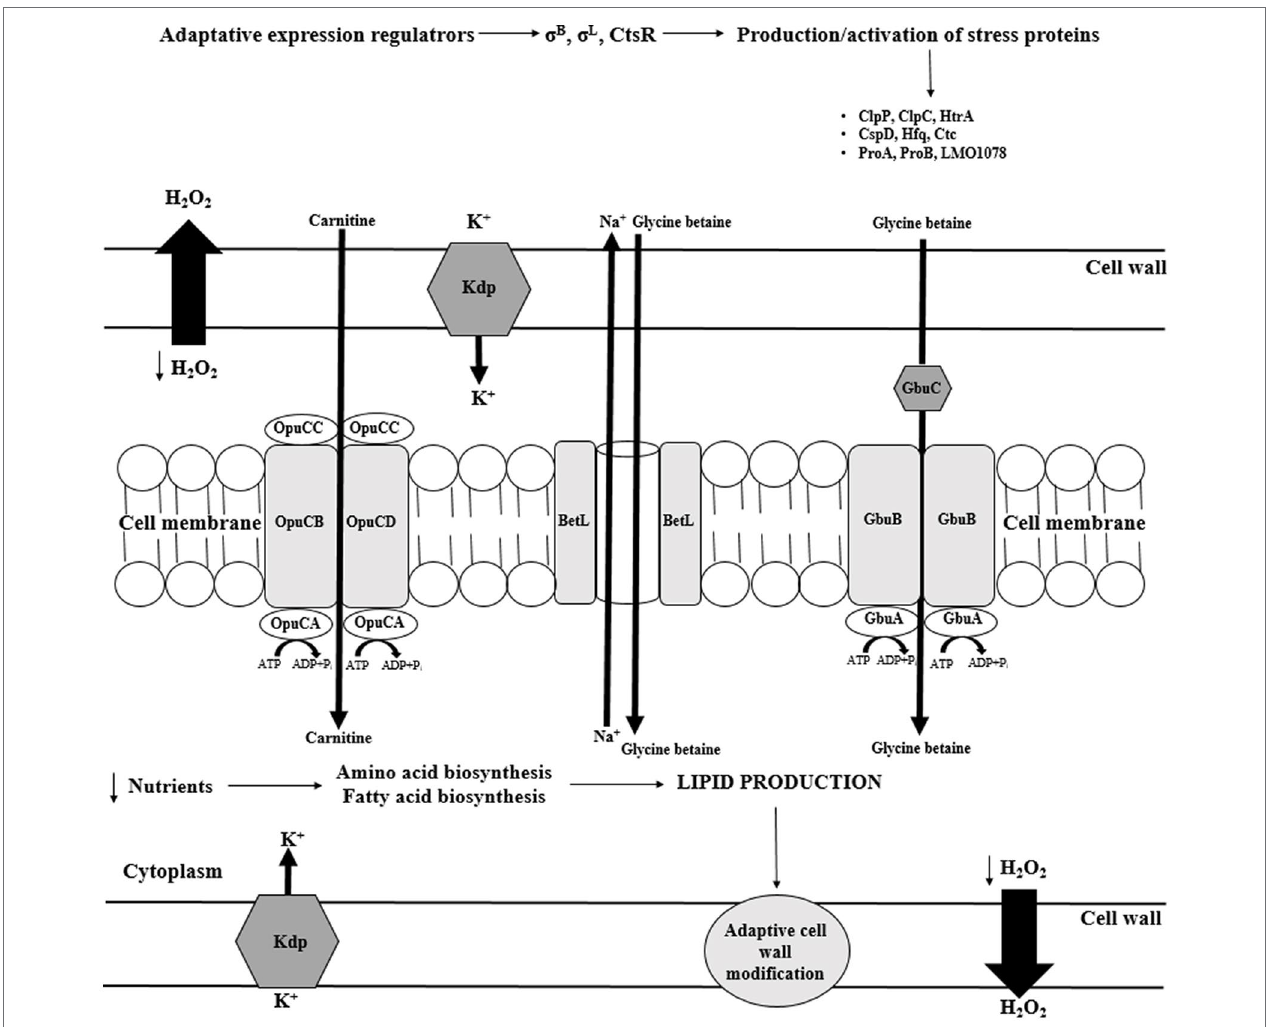
FIGURE 3 | Transport of compatible solutes in response to osmotic stress in L. monocytogenes (CtsR – negative transcription regulator; ClpP, ClpC – ATP- dependent Clp protease; HtrA – serine protease; Csp – cold shock proteins; Hfq – the RNA binding protein; Ctc – 50S ribosomal protein L25; ProBA – proline synthesis enzyme system; Kdp – operon response regulator; Gbu – glycine betaine; OpuC – ATP-dependent carnitine transporter; ATP – adenosine triphosphate; ADP – Adenosine 5 ' -diphosphate; and BetL – glycine betaine